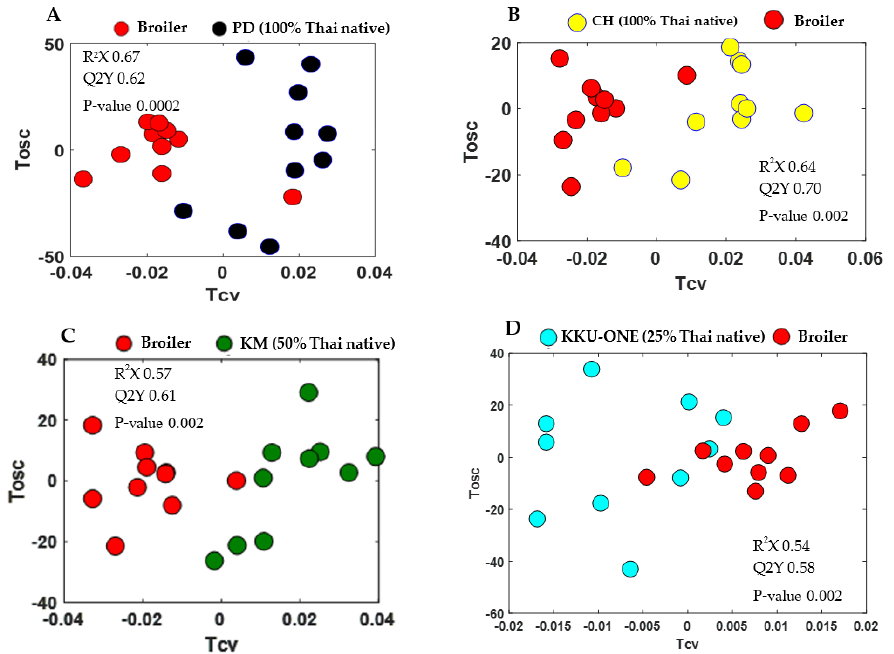
Figure 2. Orthogonal signal correction–Projection to Latent Structures–Discriminant Analysis (OPLS-DA) scores discriminating metabolites of chicken breast extracts of ( A ) commercial broilers versus PD = Pradu Hang Dam Mor Kor 55 (100% Thai native); R 2 X = 0.67, Q 2 Y = 0.62 and p -value = 0.0002, ( B ) commercial broilers versus CH = Chee KKU 12 (100% Thai native); R 2 X = 0.64, Q 2 Y = 0.70 and p -value 0.002, ( C ) commercial broilers versus KM = Khai Mook E-san (50% Thai native); R 2 X = 0.57, Q 2 Y = 0.61 and p -value = 0.002, and ( D ) commercial broilers versus KKU-ONE (25% Thai native); R 2 X = 0.54, Q 2 Y = 0.58 and p -value = 0.002.